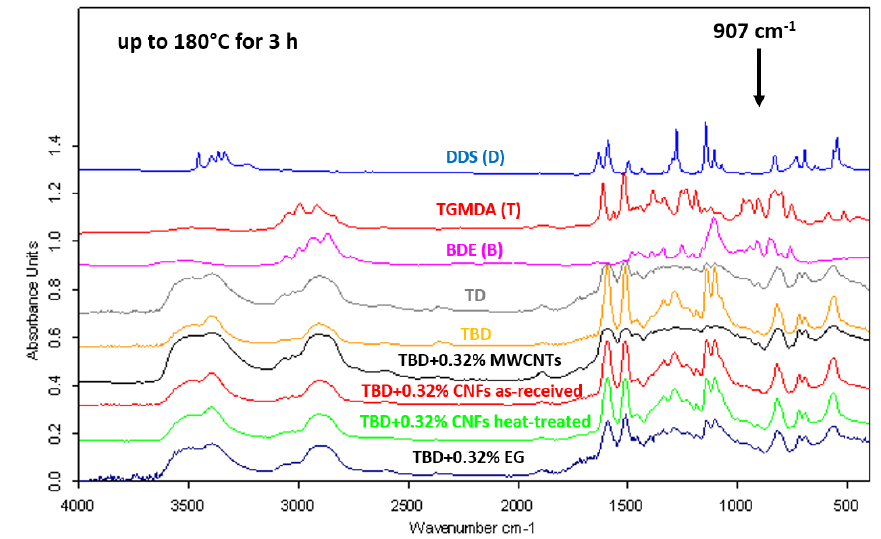
Figure 3. FTIR spectra of neat and nanocomposite systems cured up to 180°C for 3 h.